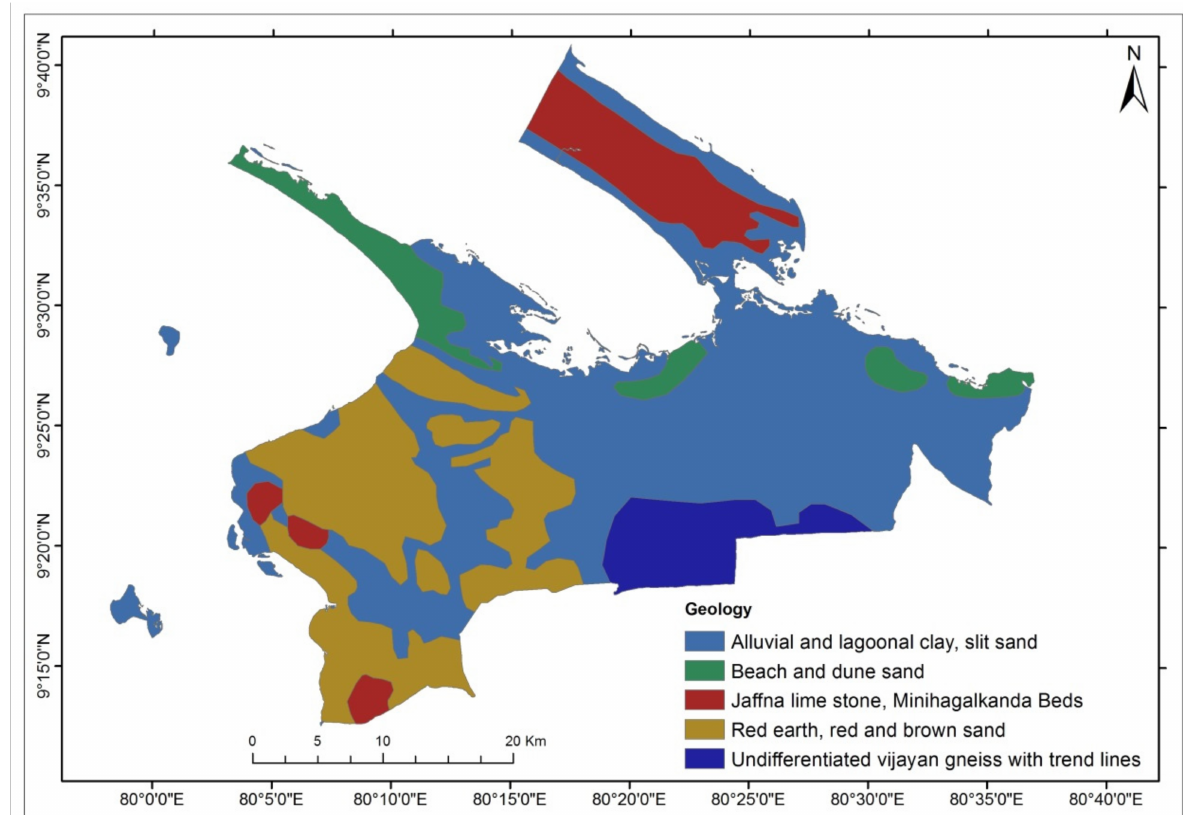
Figure 4. Geology map of Kilinochchi